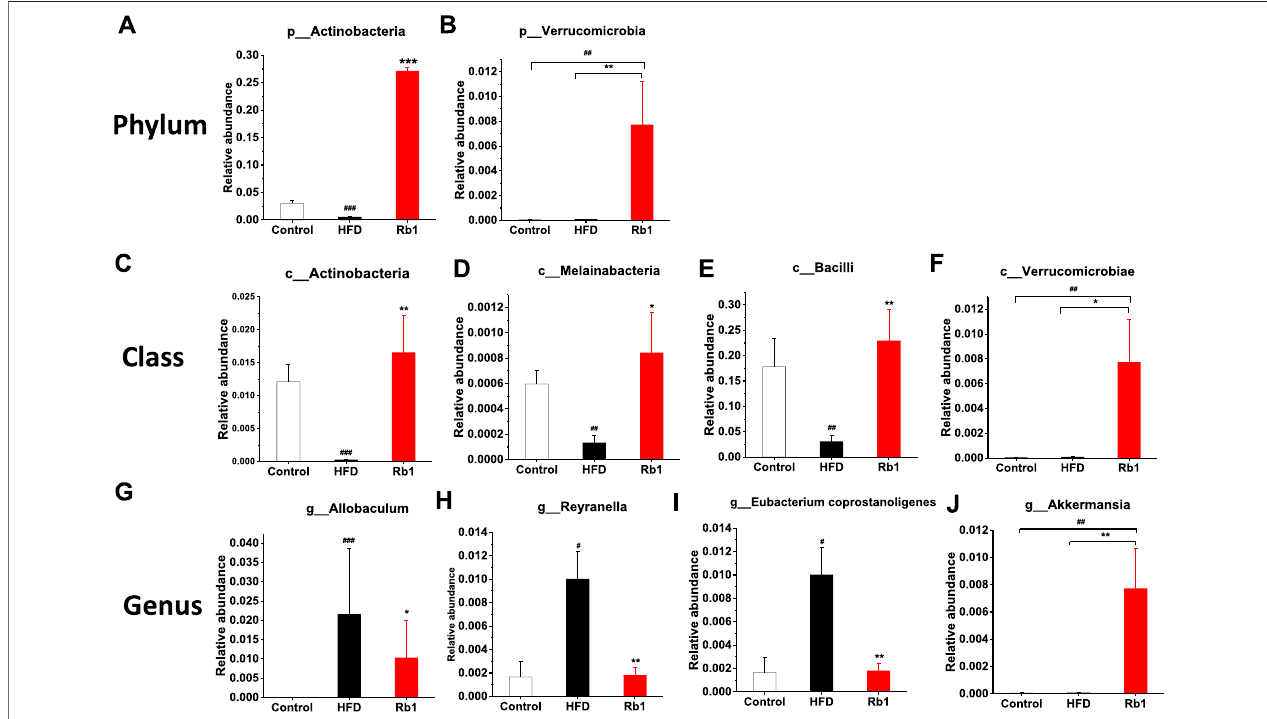
FIGURE 5 | Relative abundance of bacteria in phylum (A,B) , class (C – F) , and genus (G – J) are altered by ginsenoside Rb1. The data are expressed as the mean ± SEM;n (cid:1) 6;one-wayanalysisofvariancewithkruskal-wallispost-hoctest. # p < 0.05, ## p < 0.01,and ### p < 0.001forNCvsHFD;* p < 0.05,** p < 0.01,and*** p < 0.001 for Rb1 vs